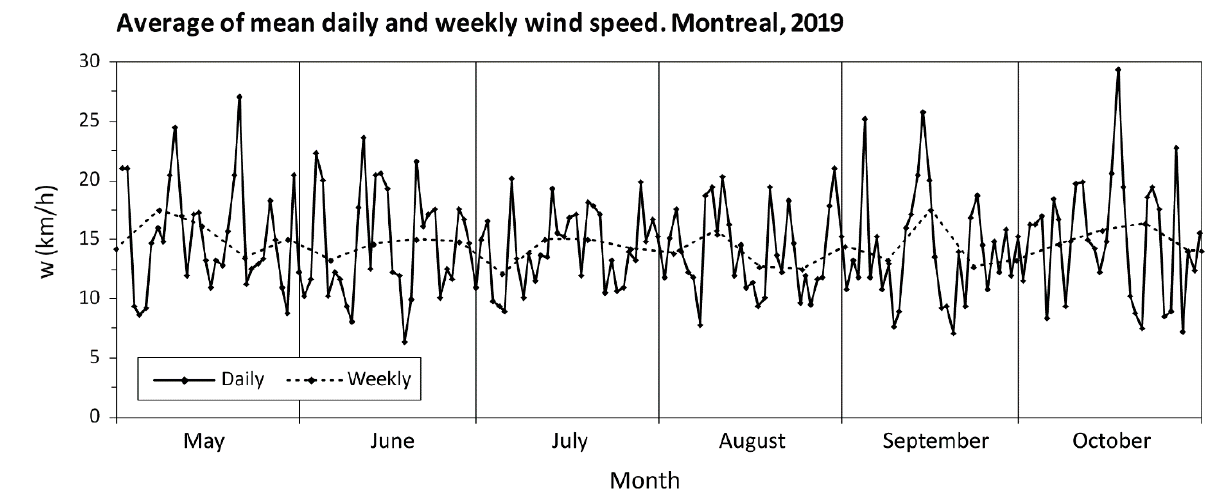
Figure 3. Daily and weekly average wind speed in Montreal 2019.